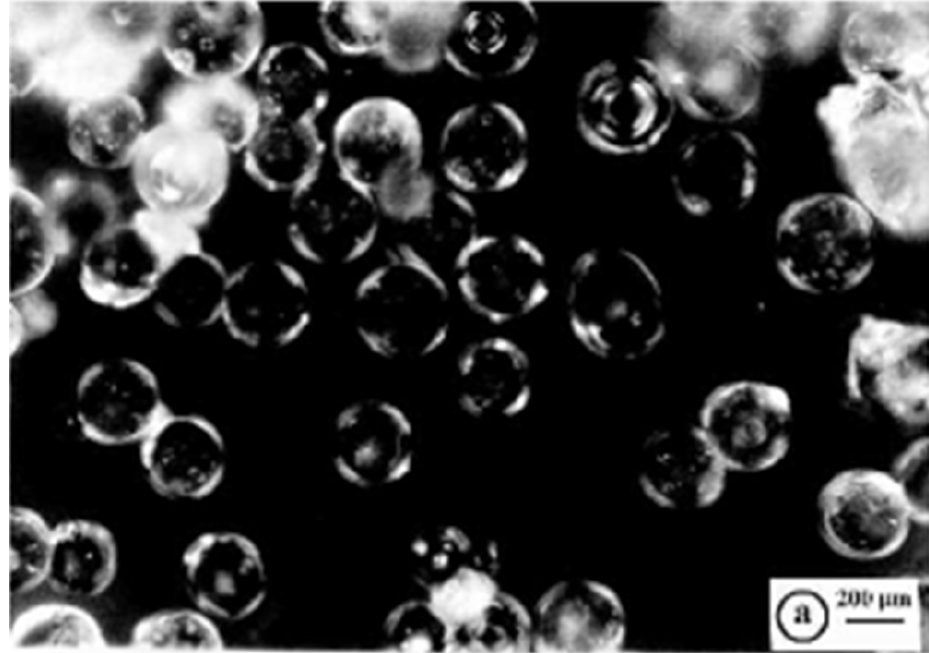
Figure 4. Optical microphotographs of dried R4 (letter a indicates the scale bar).